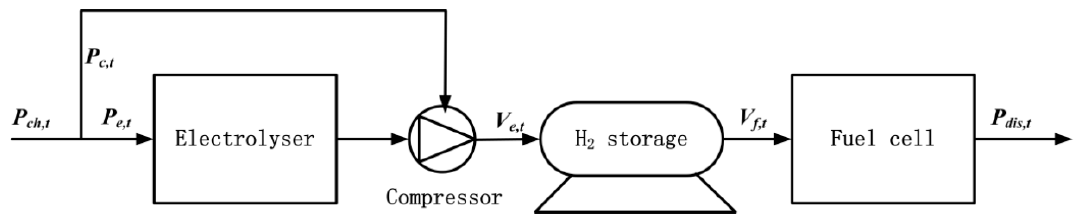
Figure 2. Structure of hydrogen storage system.